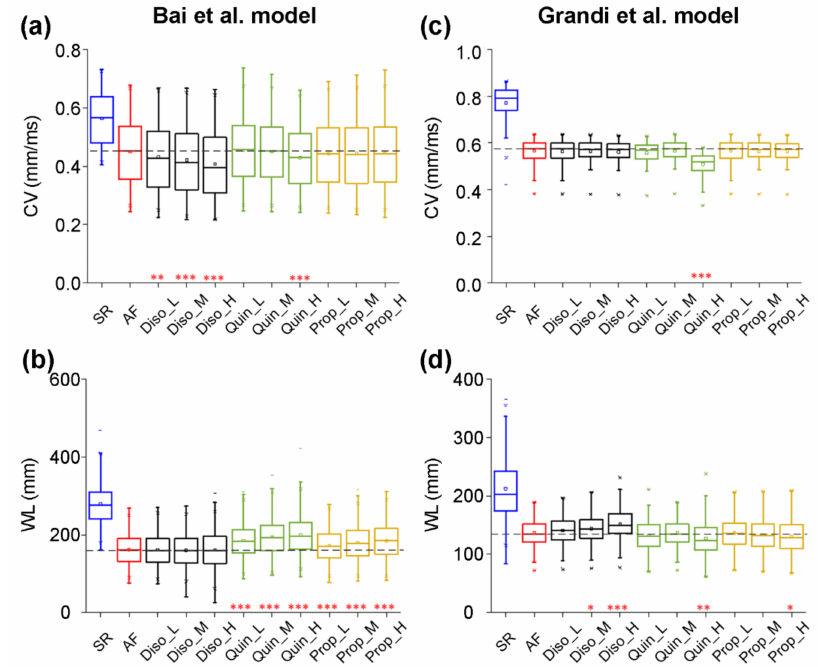
Figure 6. Effects of low (L), medium (M), and high (H) doses of disopyramide (Diso), quinidine (Quin), and propafenone (Prop) on the virtual tissue population for atrial fibrillation (AF). Using the Bai et al. model, simulated changes in conduction velocity (CV, a ) and wavelength (WL, b ) following the applications of drugs at different doses in comparison to the drug-free conditions in the AF population or in the normal population for sinus rhythm (SR). Using the Grandi et al. model, ranges of CV ( c ) and WL ( d ) in conditions of drug-free SR, drug-free AF, AF in the presence of disopyramide at low (Diso_L), medium (Diso_M), and high (Diso_H) doses, AF in the presence of quinidine at low (Quin_L), medium (Quin_M), and high (Quin_H) doses, and AF in the presence of propafenone at low (Prop_L), medium (Prop_M), and high (Prop_H) doses. Each boxplot represents the range covered by the ionic conductances: The edges of the box are the 1st and 3rd quartiles, the whiskers extend to the most extreme datapoints, the estimated median physiological value is the central horizontal line and the notch around the median is the 5% significance level (Mann–Whitney U test: * p < 0.05; ** p < 0.01; *** p <